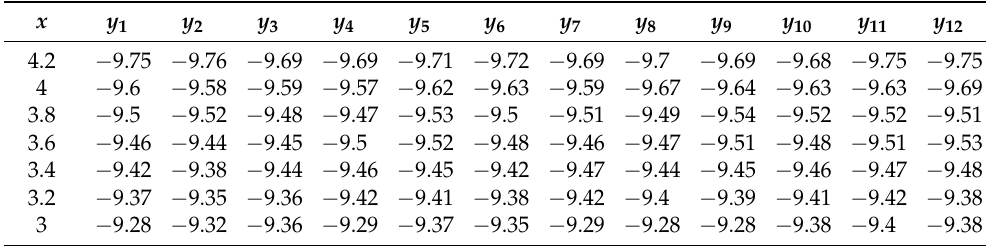
Table A4. The coordinates ( x , y ) of the ultrasound data points for the shape of the vitreous for 12 patients (part